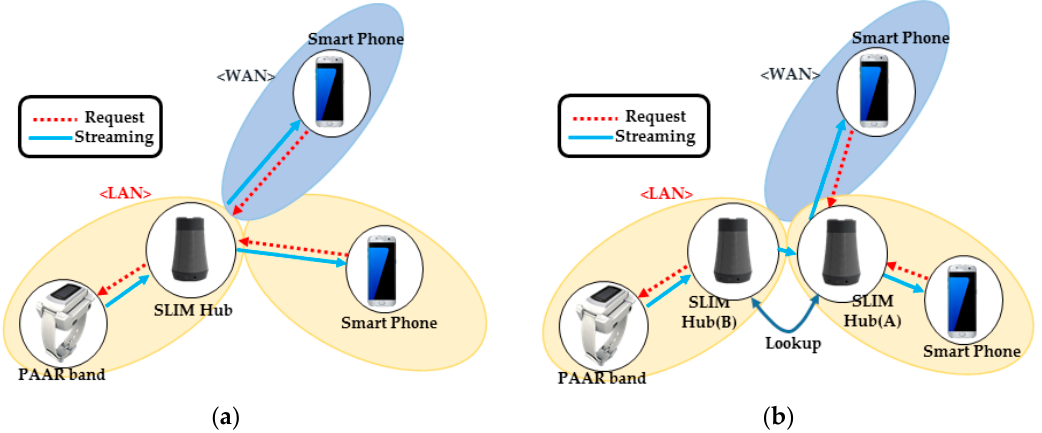
Figure 16. Experiment environment of service start time according to streaming request. ( a ) Without lookup neighbors; ( b ) Lookup neighbors.